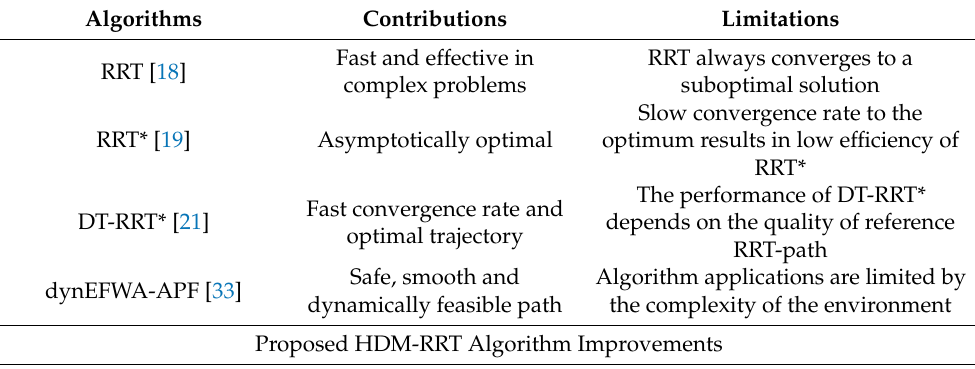
Table 1. Main contributions and limitations of existing algorithms and our approach.